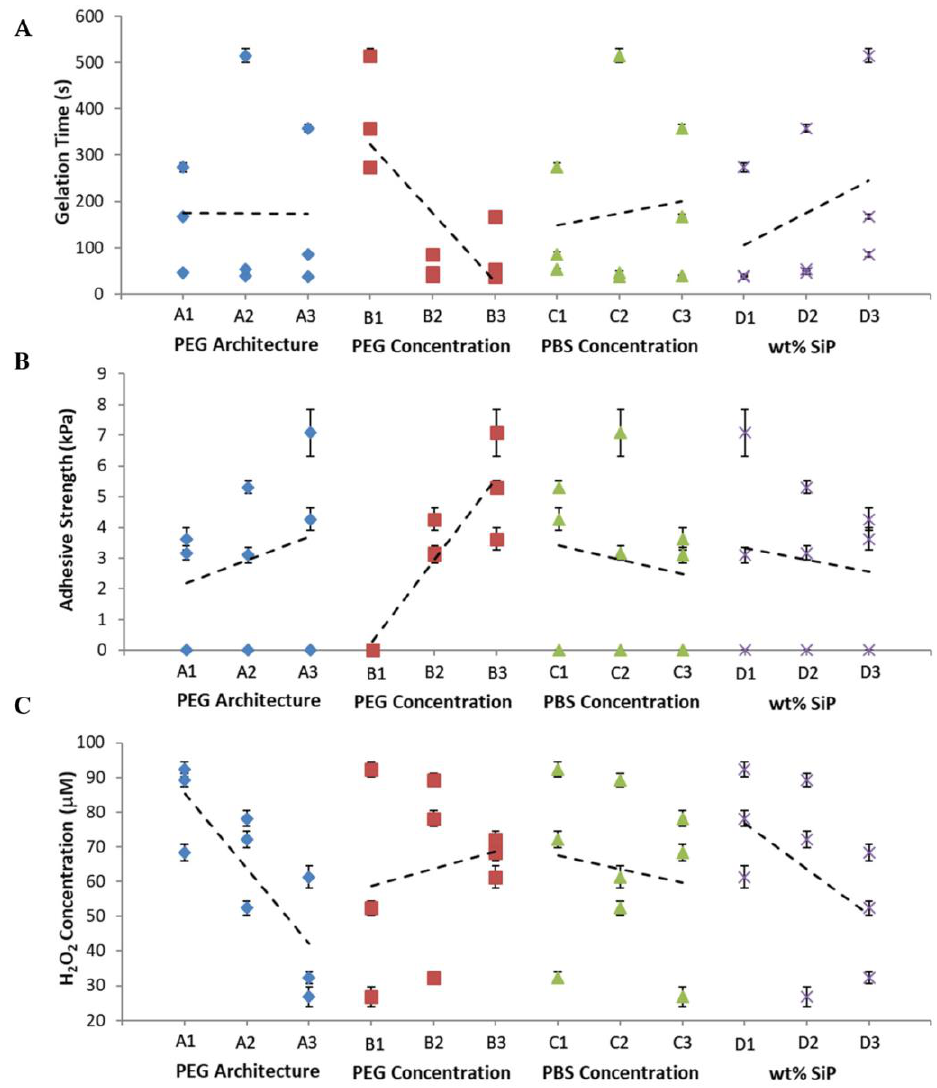
Figure 1. Average gelation time ( A ), adhesive strength ( B ), and H 2 O 2 concentration ( C ), based on the 9 adhesive formulations from Table 2. Values are plotted as means and standard deviations of experimental values for the corresponding factor levels. The dashed lines are linear trend lines.